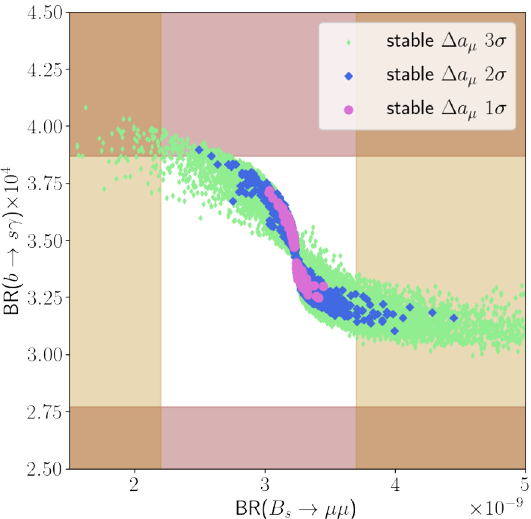
Figure 4 . Scattering plot on ( BR ( B s → µµ ) , BR ( b → sγ ) ). The color coding of the points is the same as in the previous figures. The colored regions deviate from the experimental central values by more than 2 σ